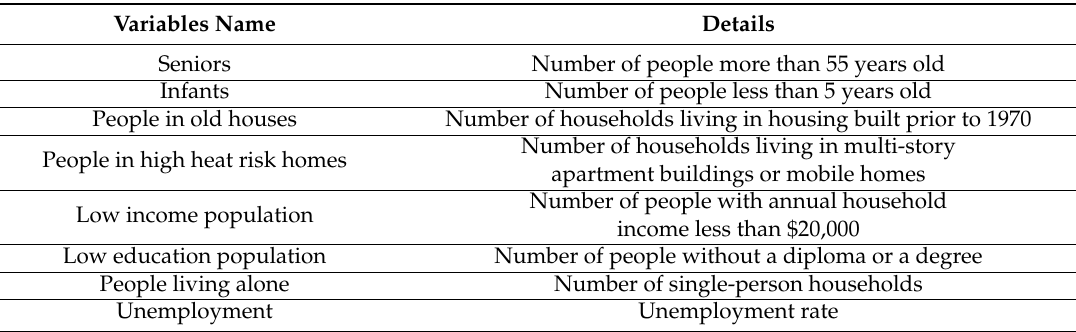
Table 1. Social vulnerability variables used to quantify heat